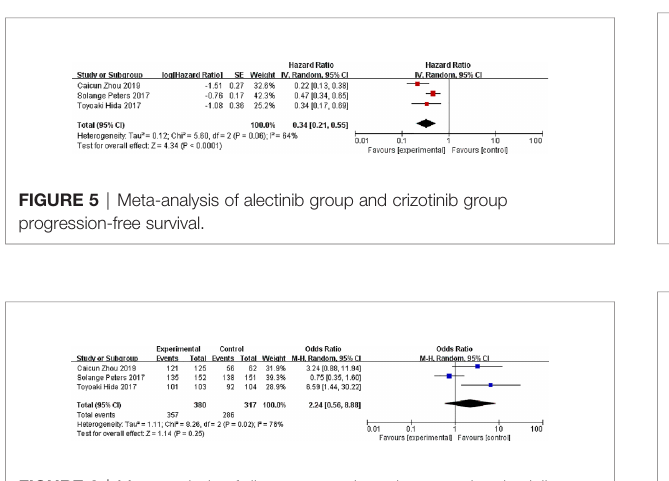
FIGURE 9 | Meta-analysis of disease stability rate between the alectinib group and crizotinib